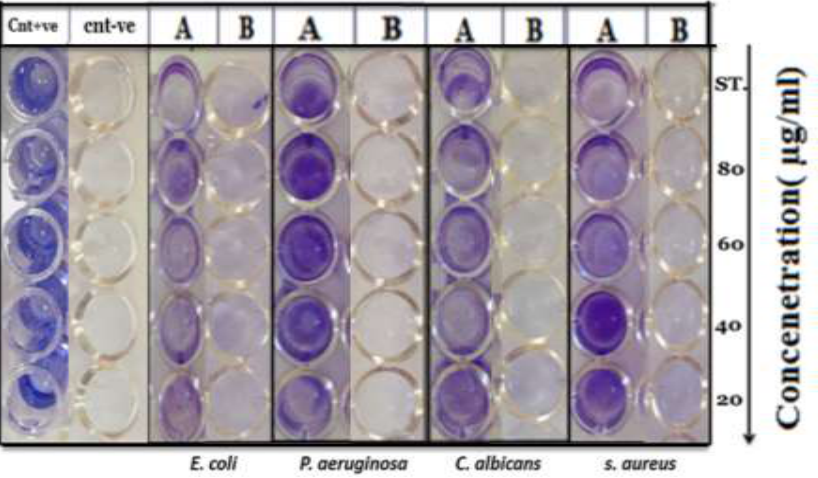
Figure 6. Quantitative detection of Inhibitory of biofilm formation by tissue culture plate method (A) Refer to bacterial supernatant only (before treatment), and (B) after treatment with biosynthesis silver nanoparticles’ for each isolates